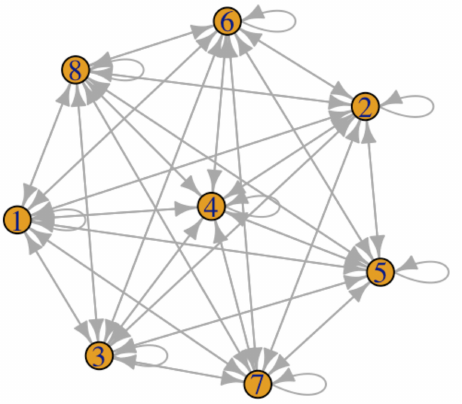
Figure 2. Fully connected adjacency matrix with 8 different types of drugs.